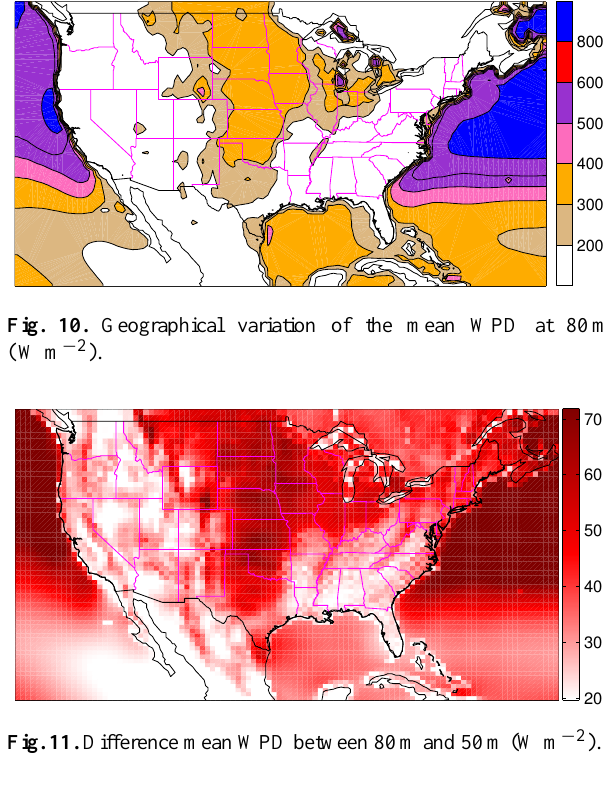
height in the contiguous US and over the off-shore regions on both sides of the